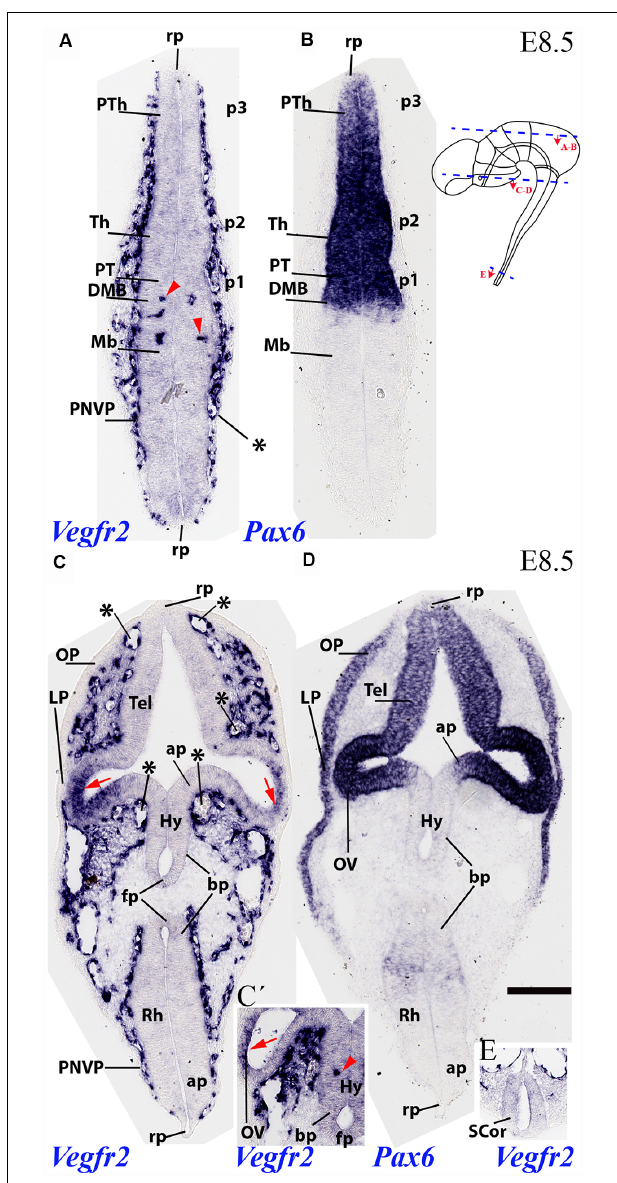
FIGURE 2 | Two horizontal sections through mouse secondary prosencephalon, diencephalon and mesencephalon at E8.5 showing varying degrees of external vascularization by the PNVP (labeled with endothelium-selective Vegfr2 riboprobe; A , C ), compared in consecutive sections with Pax6, an alar plate marker for the diencephalic neuromeres p1-p3 (B) and the secondary prosencephalon (telencephalon and optic vesicle in D ). Inset to (B) : semi-schematic representation of the plane of section of the horizontal sections (A,B) and (C,D) . Note the PNVP-nude roof plate area rostrally and caudally (rp; A ). The earliest Vegfr2-positive perforant vessels are marked with red arrowheads in (A) and inset ( C’ ; detail of alar hypothalamus, Hy). The red arrows in (C) point to areas of non-vascular Vegfr2 expression at the neural retina primordia. Note also in (C) the remarkable lack of PNVP at the forebrain and hindbrain floorplate (FP) and neighboring basal plate (bp). The median and paramedian perichordal mesoderm also lacks vascularization, in contrast with lateral mesoderm areas next to the neural alar plate (unlabeled). Inset (E) shows the very retarded state of vascularization at the spinal cord (SCor). Asterisks: developing venous seins. Scale bar: 150 µ